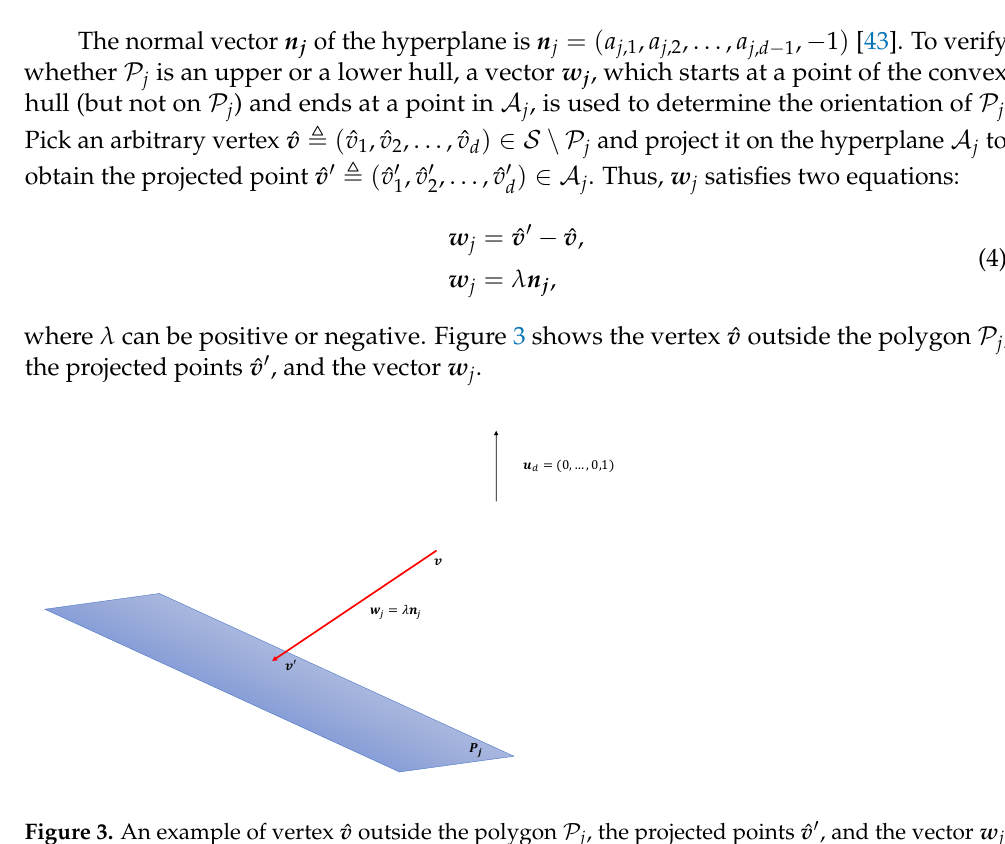
Figure 3. An example of vertex ˆ v outside the polygon P j , the projected points ˆ v (cid:48) , and the vector w j . In addition, n j is the normal vector of P j and u d is the standard unit vector parallel to the x d